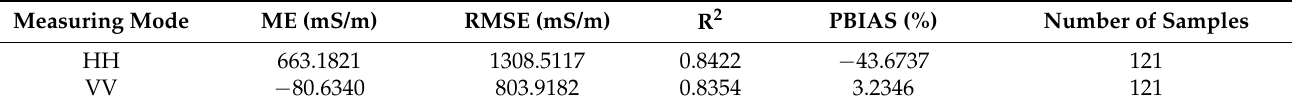
Table 9. Statistical data for accuracy assessment of the IDW